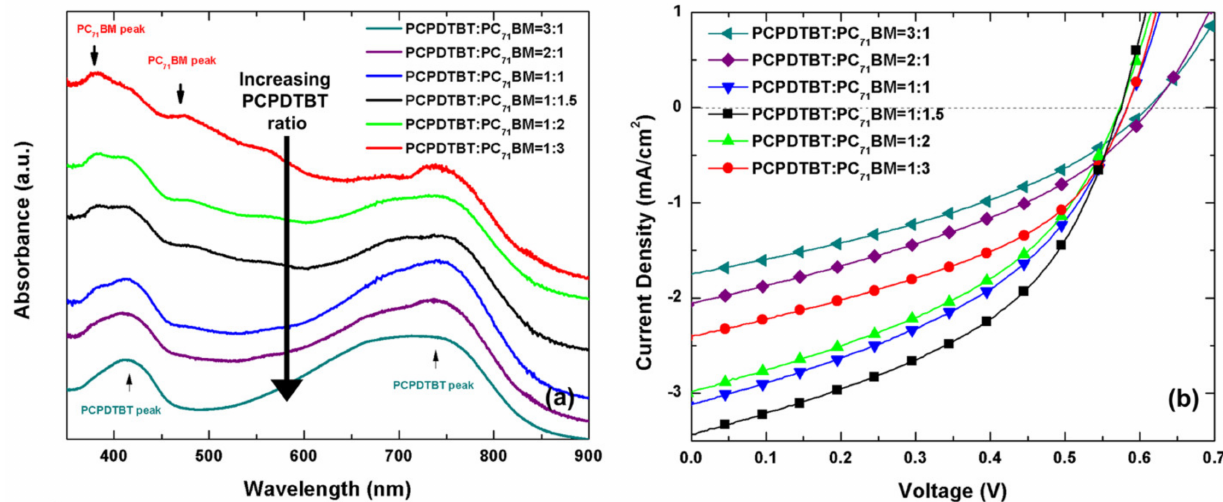
Figure 5. ( a ) UV–Vis–NIR absorption spectra of PCPDTBT:PC71BM layers (with different ratios between the components) obtained by sequential deposition mode. ( b ) J–V characteristics of the structures based on PCPDTBT:PC71BM films. Reprinted with the permission from [69]. Copyright 2014 AIP